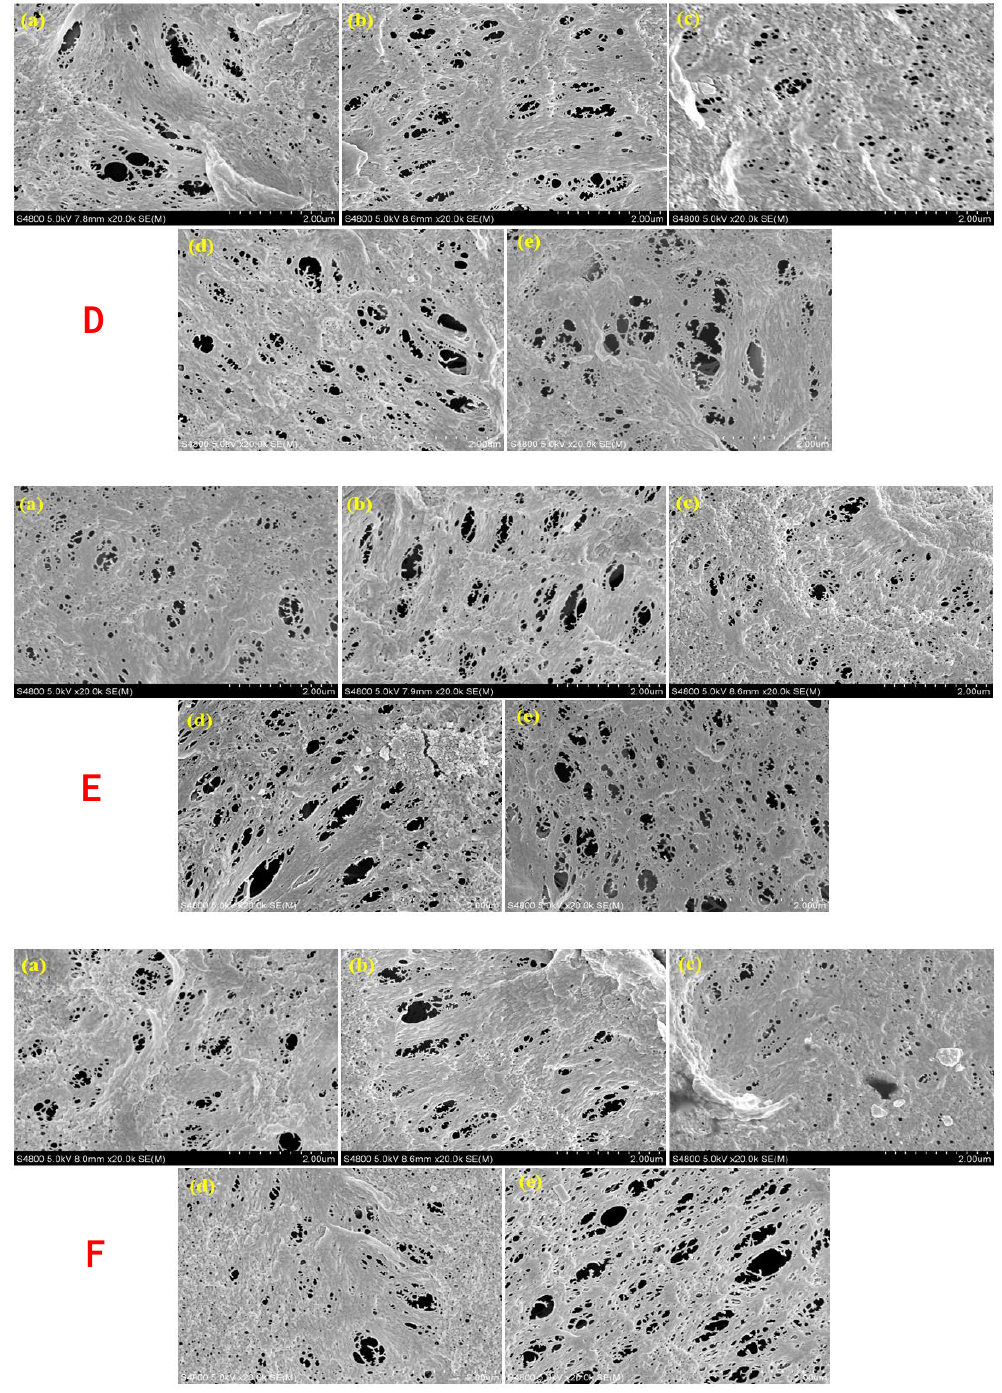
Figure 2. SEM images of the top surface of PVDF-Neat ( A ), PVDF-1 ( B ), PVDF-2 ( C ), PVDF-4 ( D ), PVDF-8 ( E ) and PVDF-15 ( F ) membranes on ( a ) Day 7, ( b ) Day 28, ( c ) Day 56, ( d ) Day 84 and ( e ) Day 112.